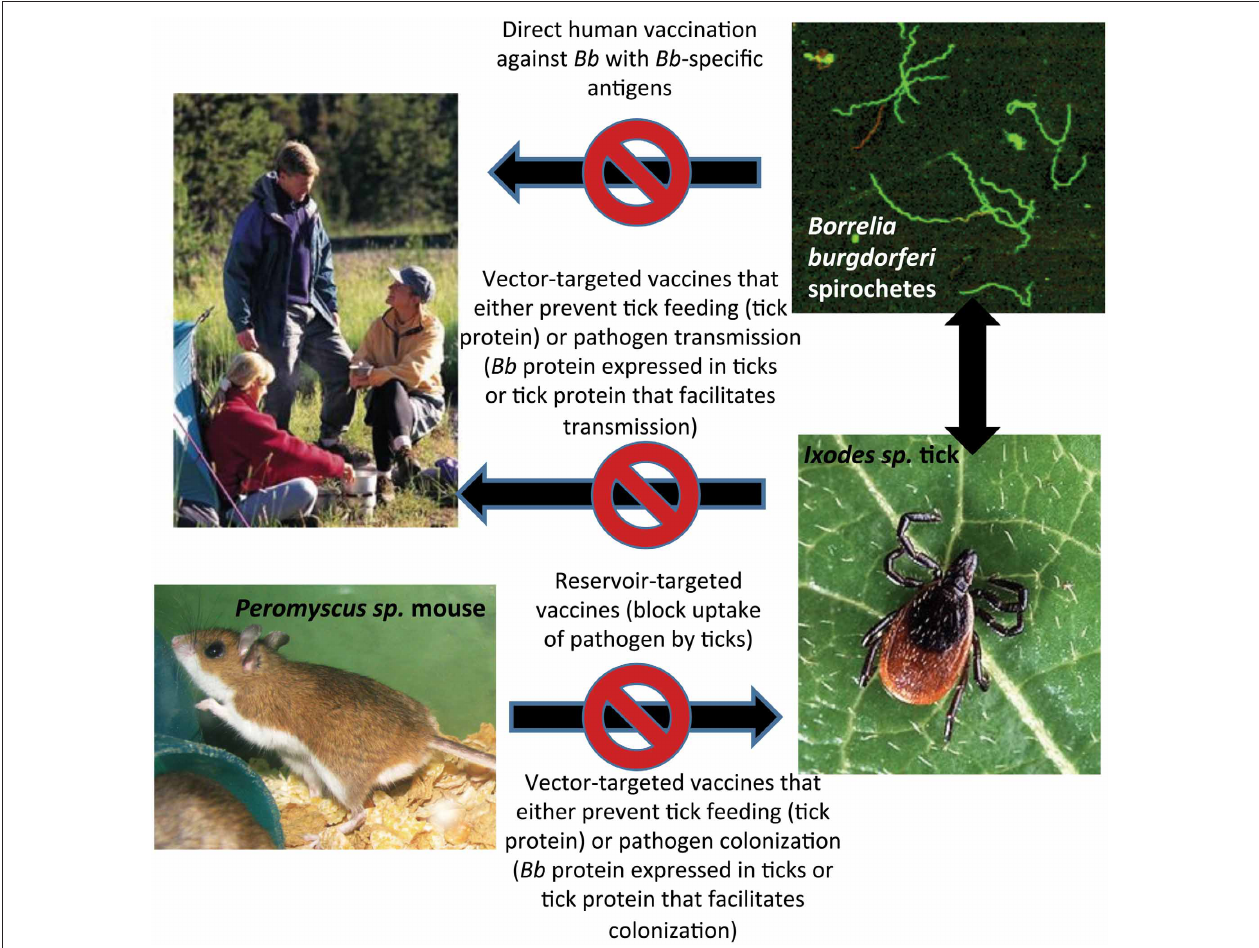
FIGURE 1 | Points at which interruption of B. burgdorferi transmission to humans can be achieved through